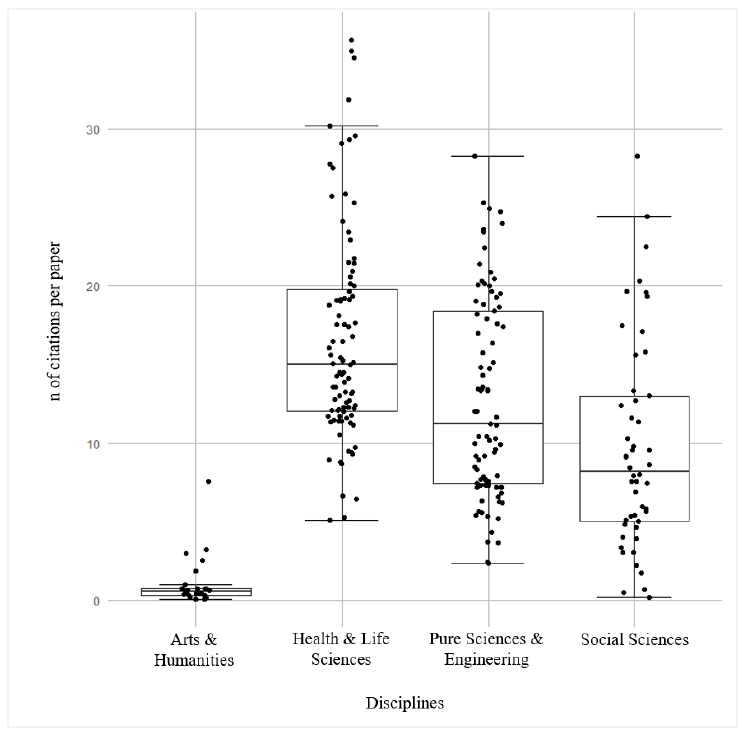
Fig. 1. Distribution of citations per paper for the four